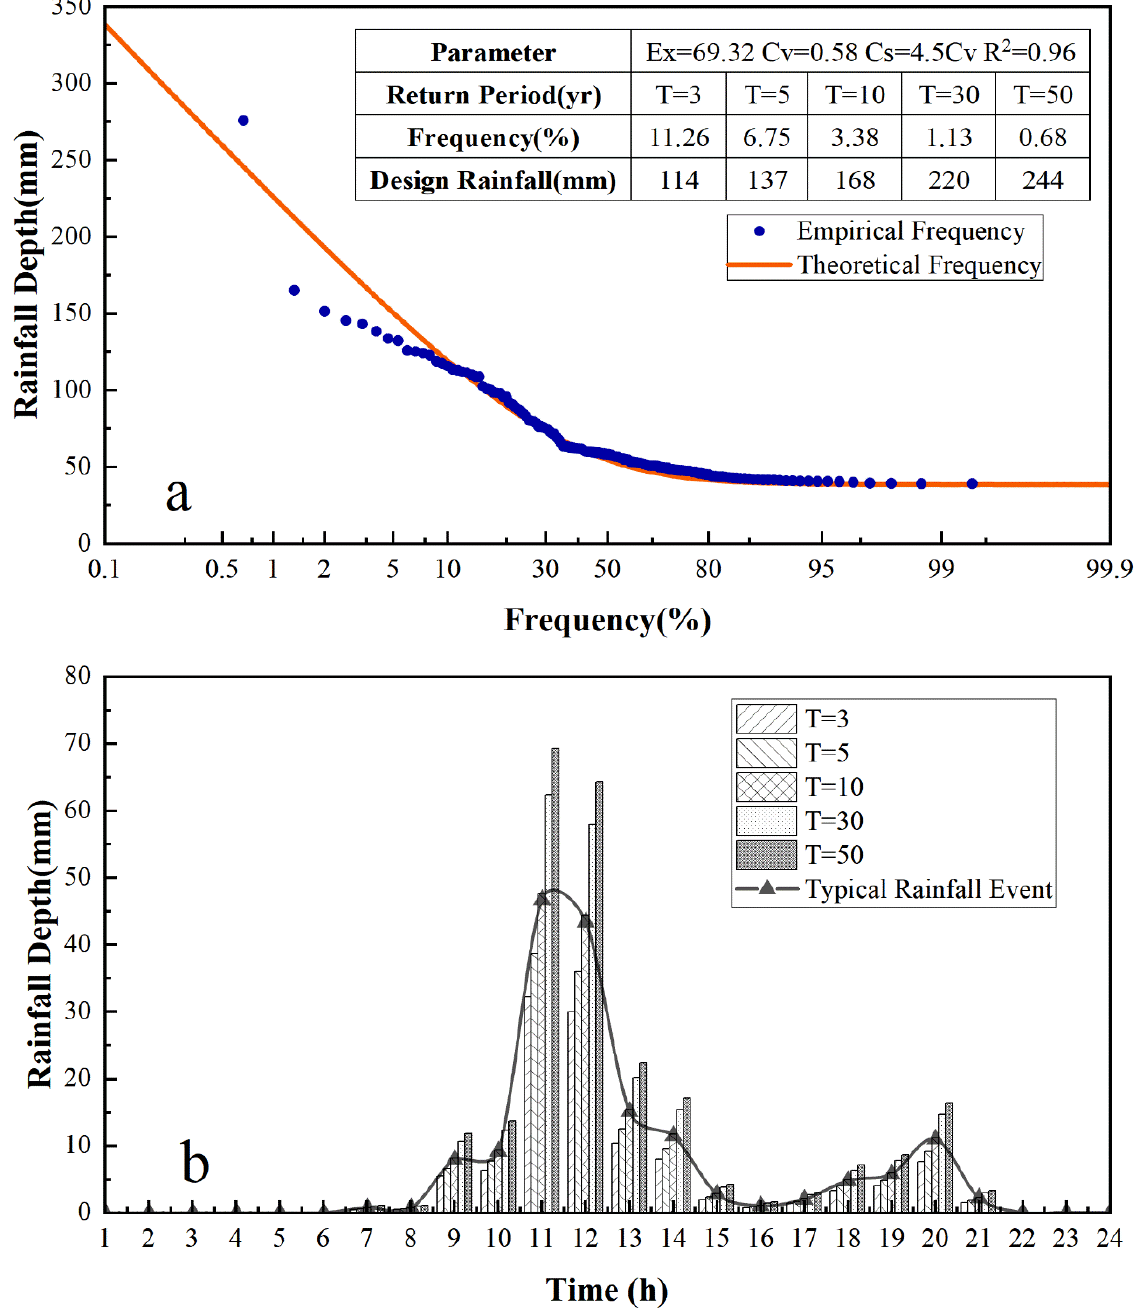
Figure 2. ( a ) The frequency curve of the designed rainfall; ( b ) typical rainfall process and designed rainfall process under different return periods.